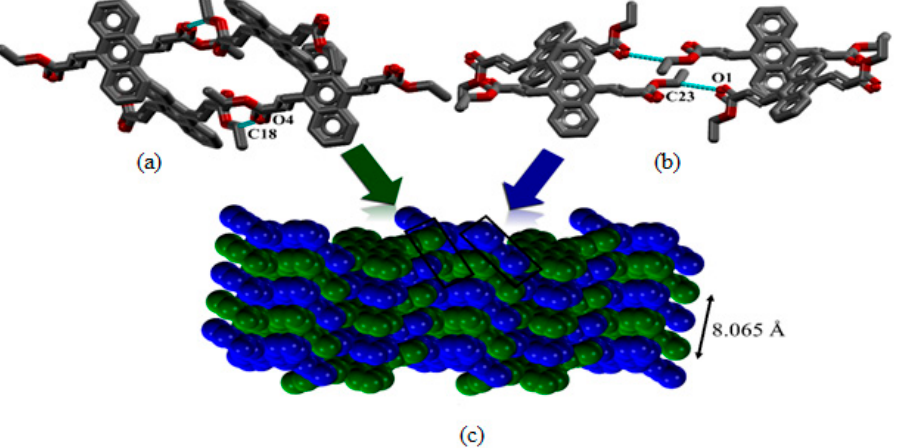
Figure 6. Two independent chains formed by weak intermolecular interactions of DADB ( a , b ); followed by the supramolecular arrangement in ( c ). Similar chains are separated by 8.065 Å, represented by the green and blue colors.